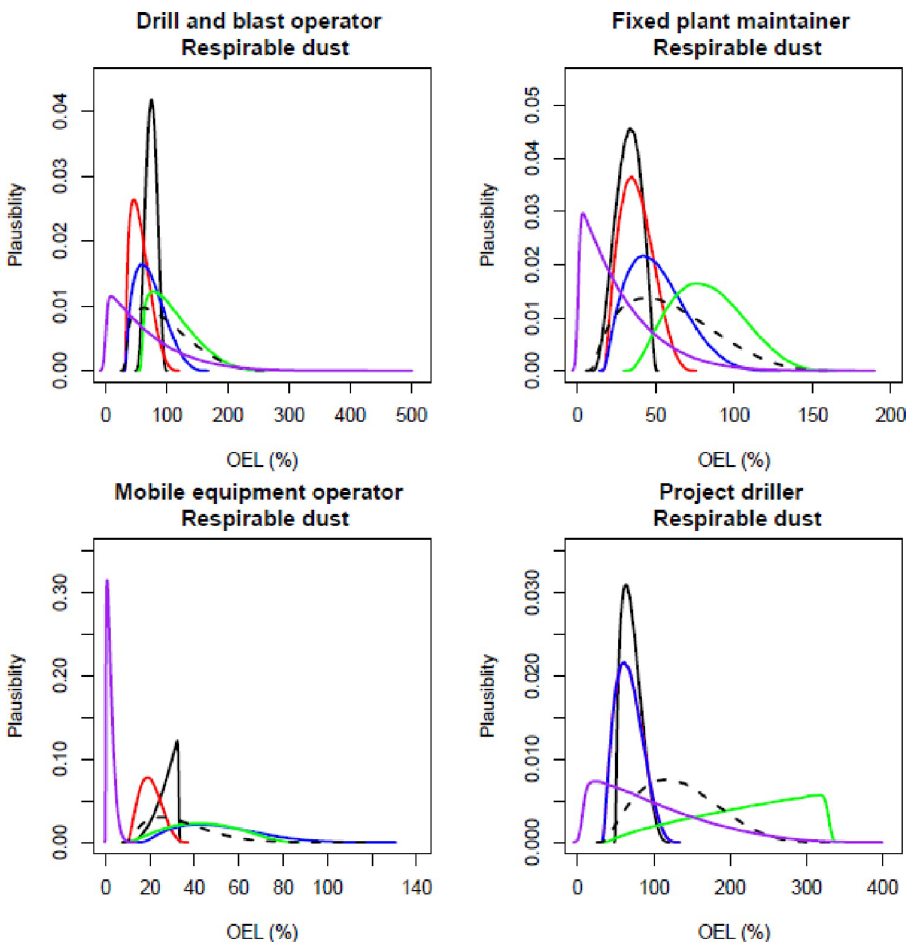
Fig 6. Expert estimates and measured data of respirable dust percentage of occupational exposure limit (OEL). Each curve depicts the experts support (probability density) or measured data encoded into a scaled Beta distribution. Experts are denoted in the colours blue, red, black and green; combined experts are the dashed line. Measured data is presented as purple.